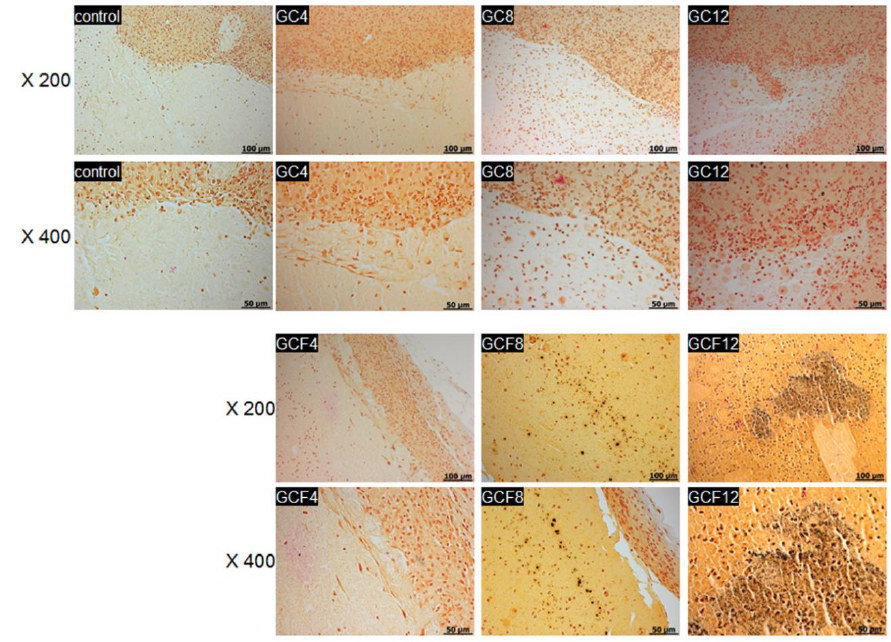
Figure 7. von Kossa-stained sections of the MCL without (GC) and with (GCF) the osteogenic factors after 4, 8, and 12 weeks and the MCL only without hEBs and osteogenic factors as control. The numbers indicate the implantation time and the scale bars indicate 100 µm for the ×400 magnification and 50 µm for the ×200